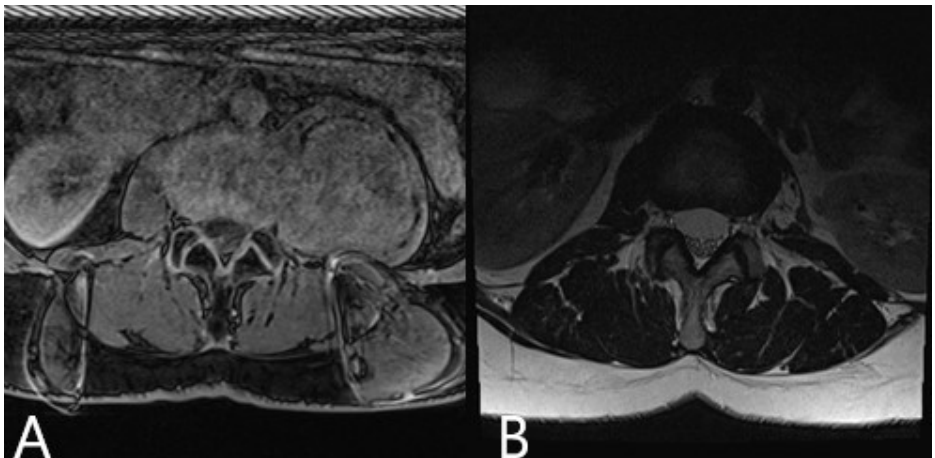
Figure 7. Same patient as in Figure 5 (patient no. 9). MRI of the lumbar spine. ( A ) Preoperative axial post-contrast MRI of the lumbar spine shows large left-sided retroperitoneal tumor with origin in the left L1/2 neuroforamen. ( B ) Postoperative axial T2 MRI of the lumbar spine shows complete resection of the neurinoma at the three-month follow up.